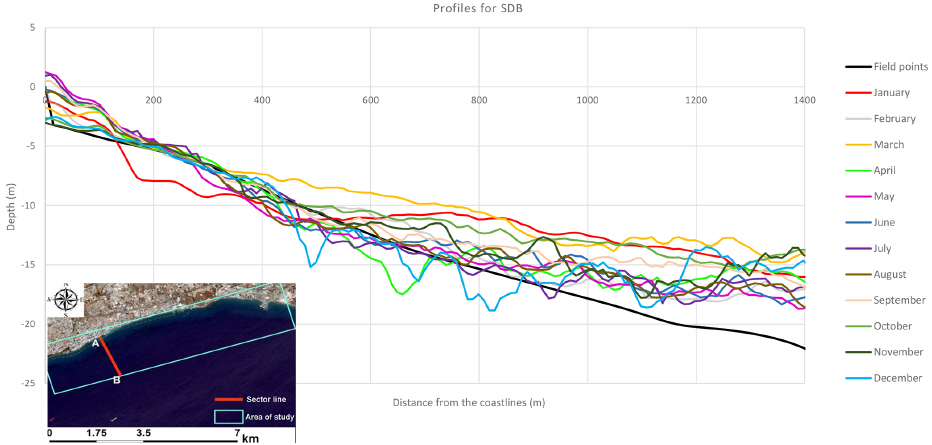
Figure 7. Sector profiles of